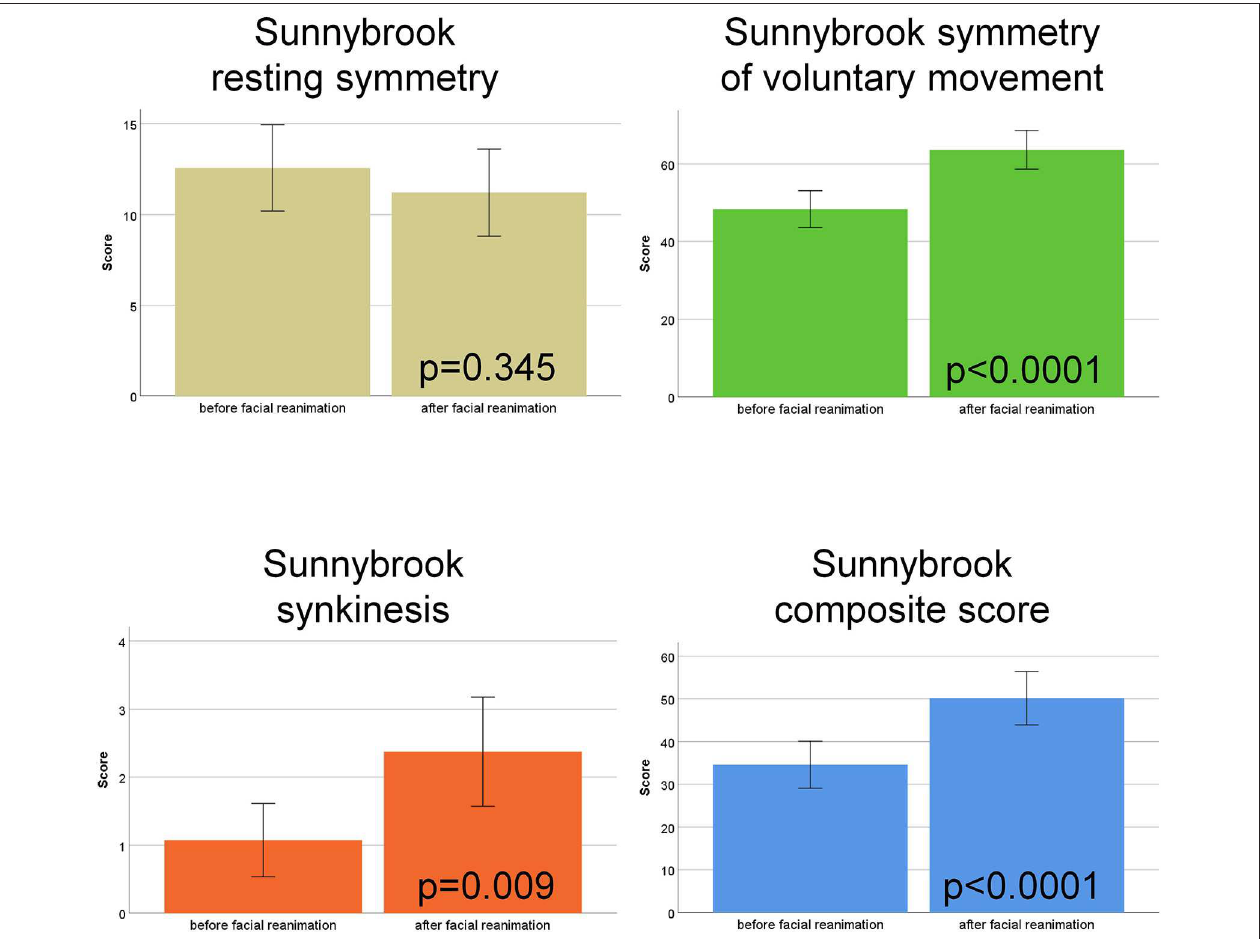
FIGURE 1 | Sunnybrook facial nerve grading. Comparison of the scores before vs. after hypoglossal-facial jump nerve suture. The four subscores (Resting symmetry, Symmetry of voluntary movement, Synkinesis, Composite score) are shown in different colors.